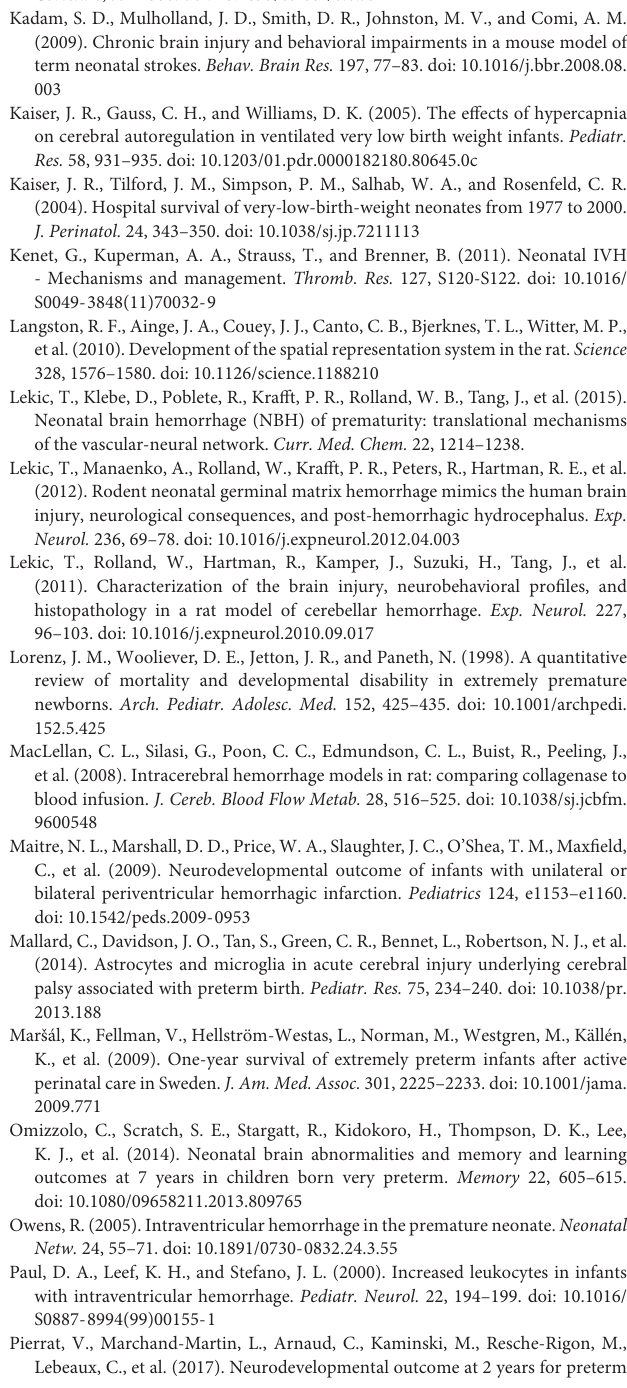
collagenase ( n = 19) groups. Data represented as individual animals ± SEM and analyzed using one-way ANOVA followed by Tukey’s multiple comparison